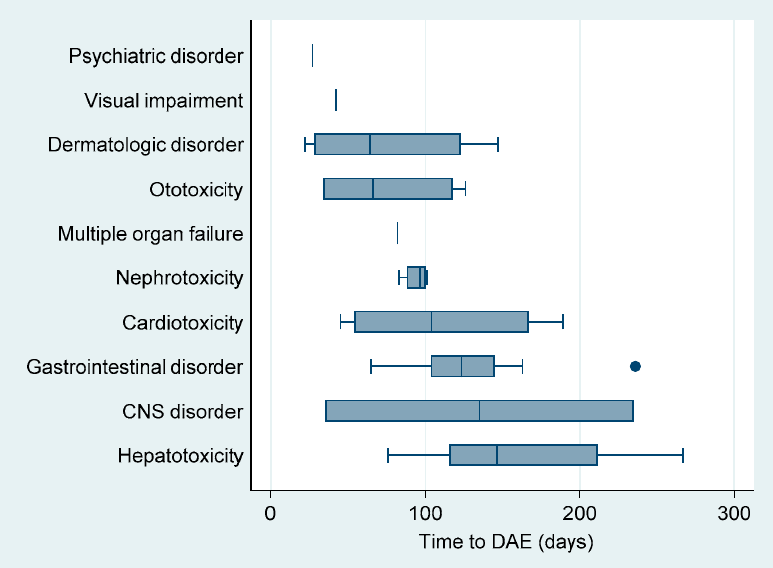
Figure 2. Boxplot of median time until onset of drug adverse event in patients on shorter treatment regimens in RR/MDR-TB patients in Uzbekistan.